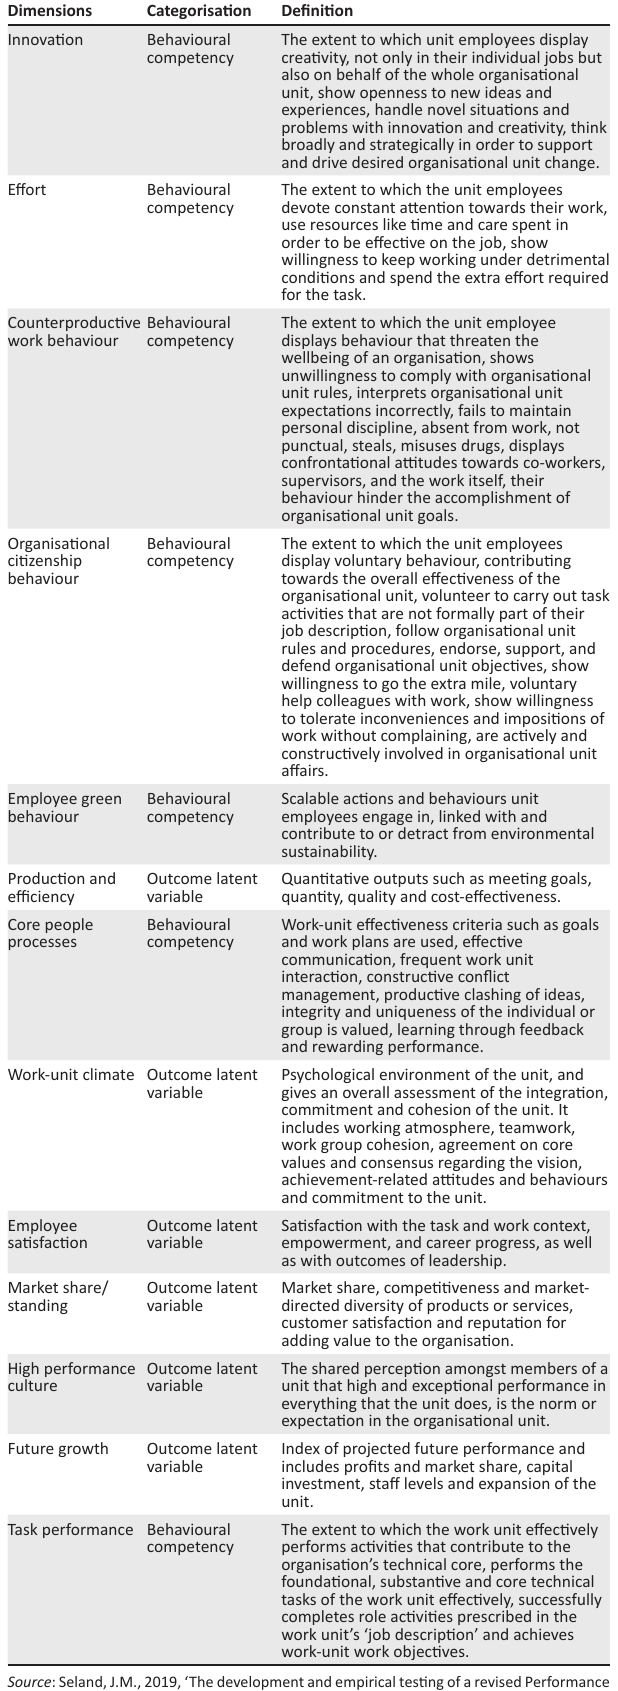
TABLE 2 : A summary of the seven latent behavioural competencies and six latent outcome variables included in the organisational work-unit performance